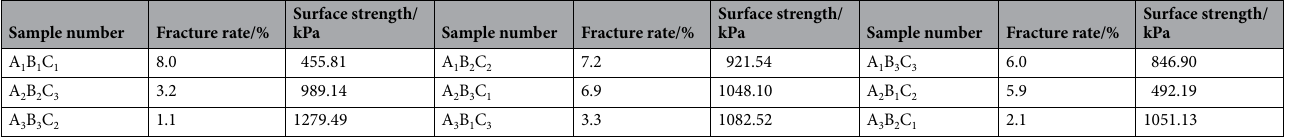
Table 5. Dry shrinkage orthogonal test